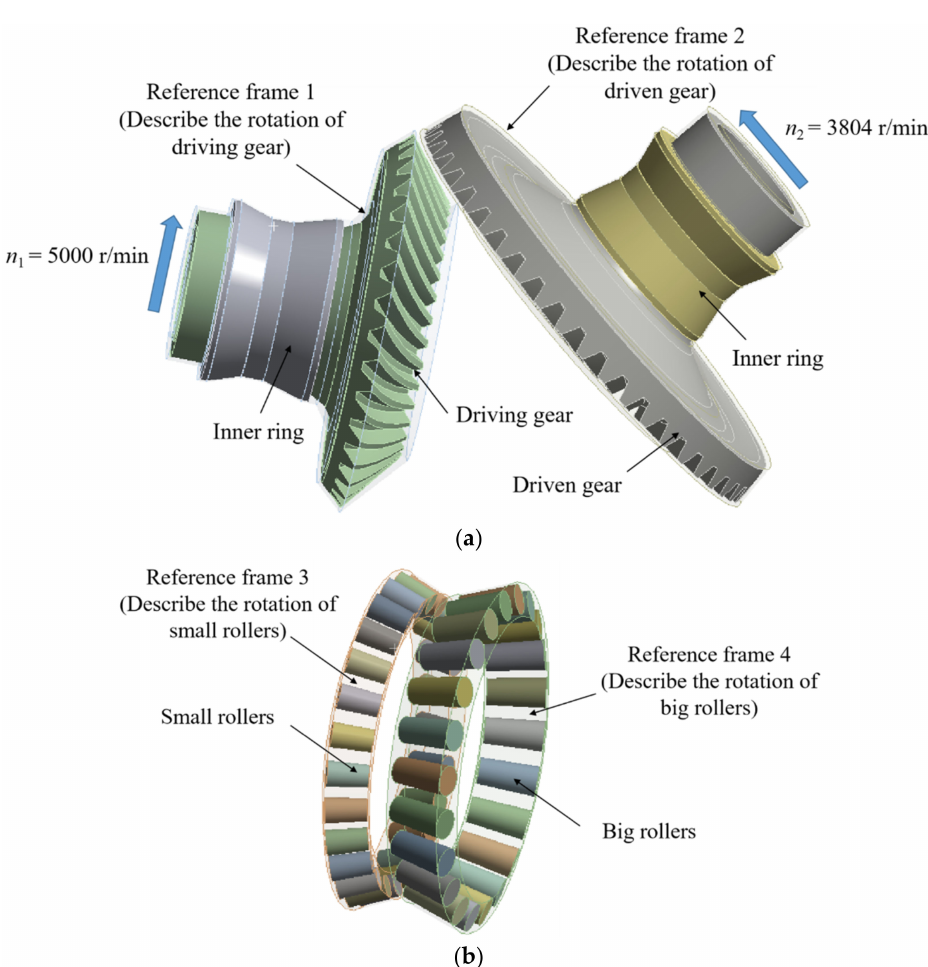
Figure 5. Moving reference frames of the computational model: ( a ) moving reference frame for gears; ( b ) moving reference frame for